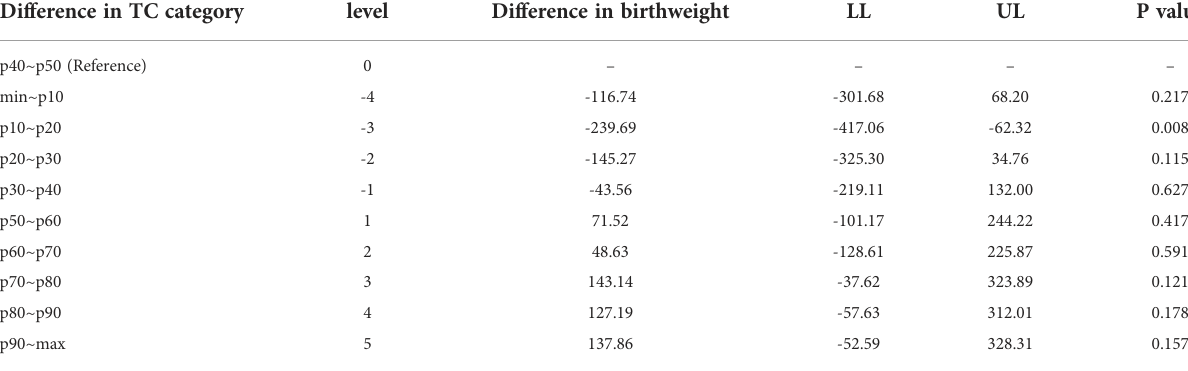
TABLE 3 Association between the difference in 2 nd -trimester TC and difference in birthweight. Difference in TC